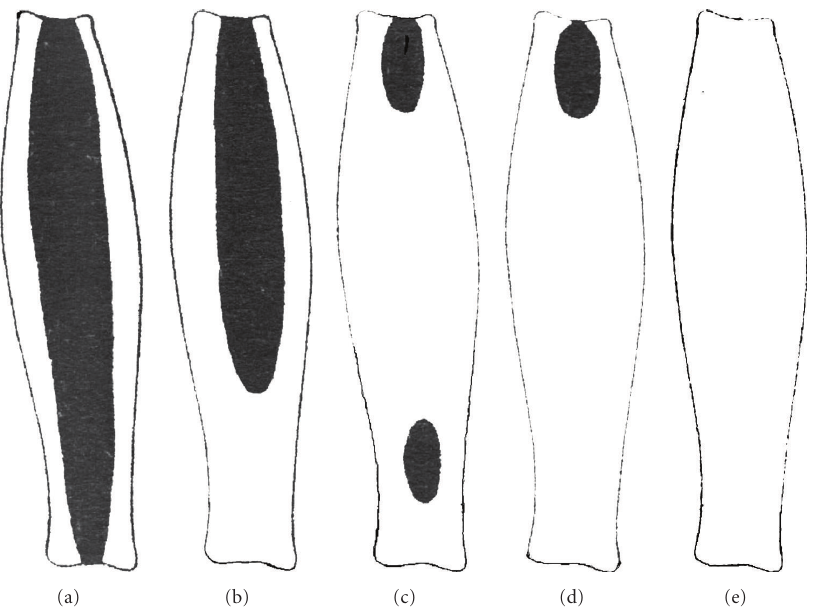
Figure 2: Variants of coloring of dorsal side of hind leg femur in I. maculator F. adults [14].